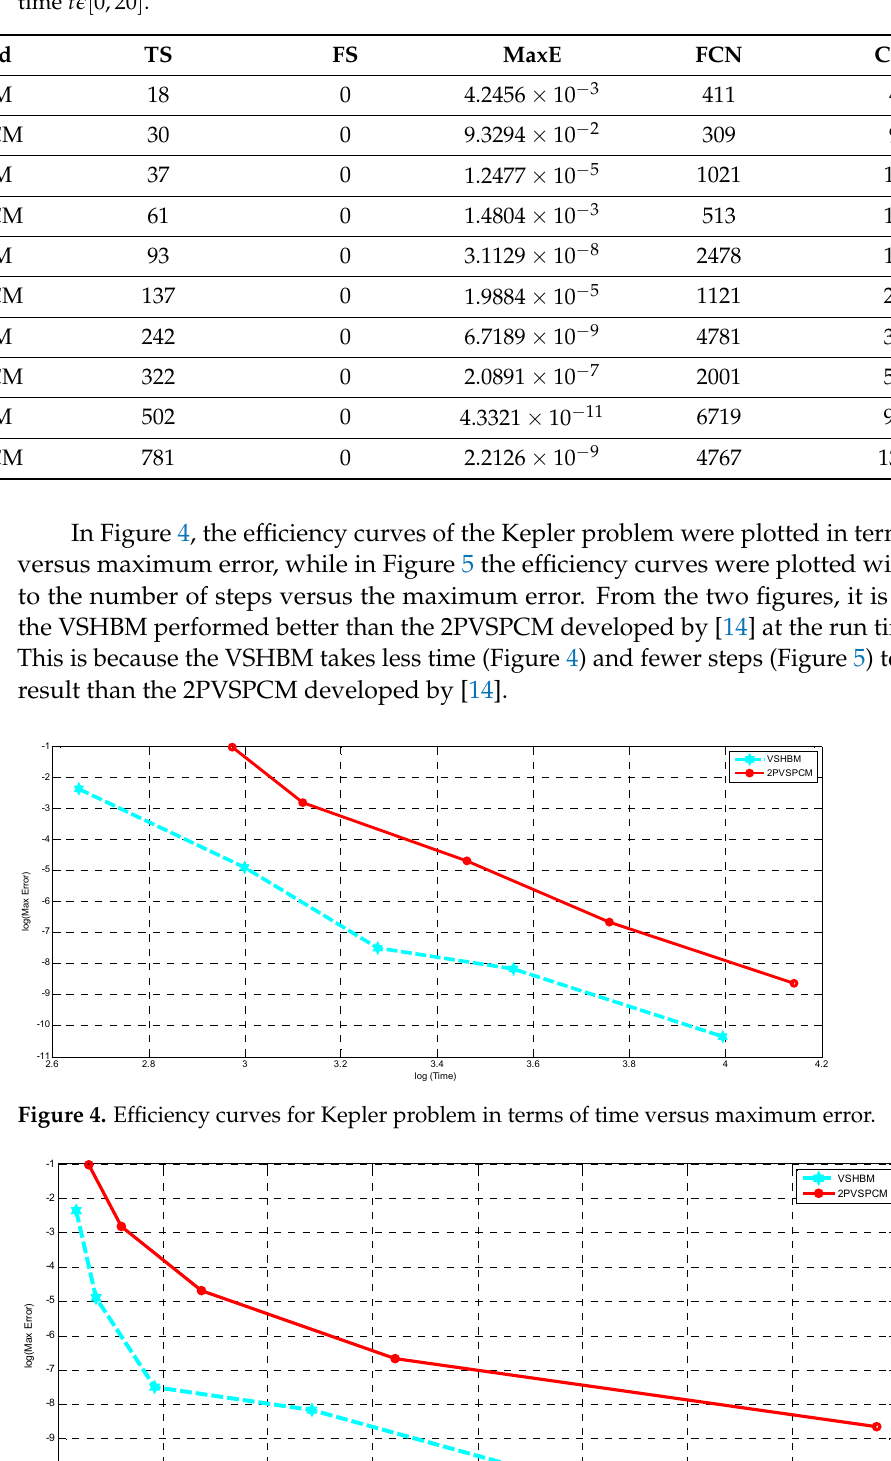
ferent eccentricities 1 − 𝑒 = 0.1, 0.001 and 0.00001 . Different tolerance levels were con- sidered in the computation. The results generated show that no step failed (i.e., FS = 0) and the accuracy of the VSHBM increases as 1 − 𝑒 reduces or tends to zero.